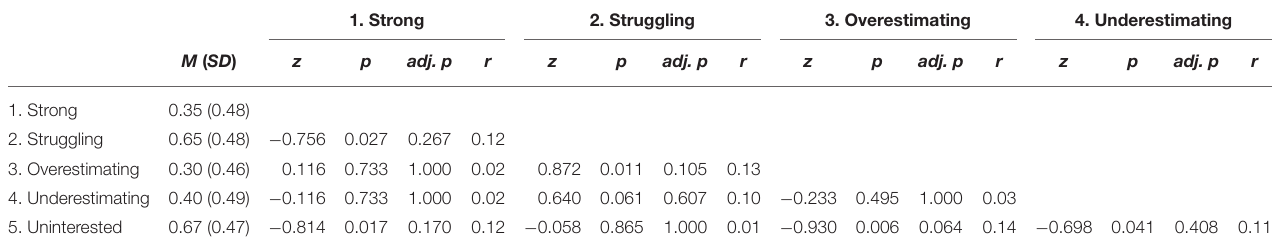
TABLE 3 | Post-hoc tests comparing judgment accuracy among student